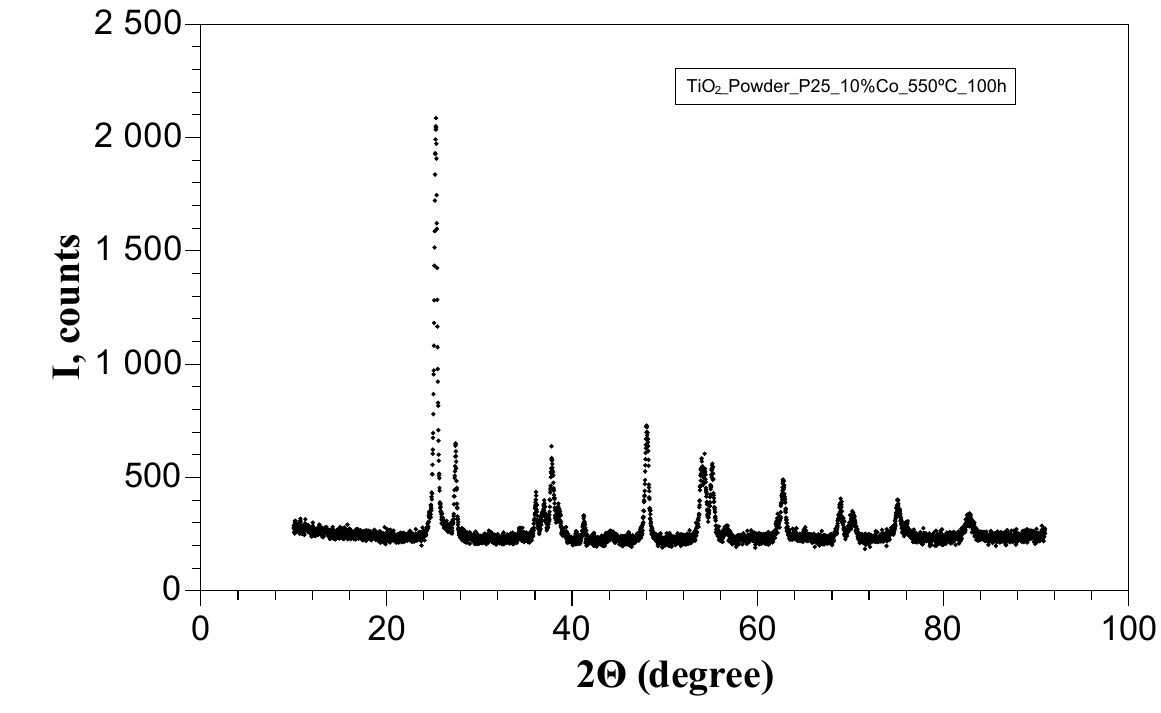
Figure 2. XRD Diffraction pattern of the sample TiO 2 :0.1Co.